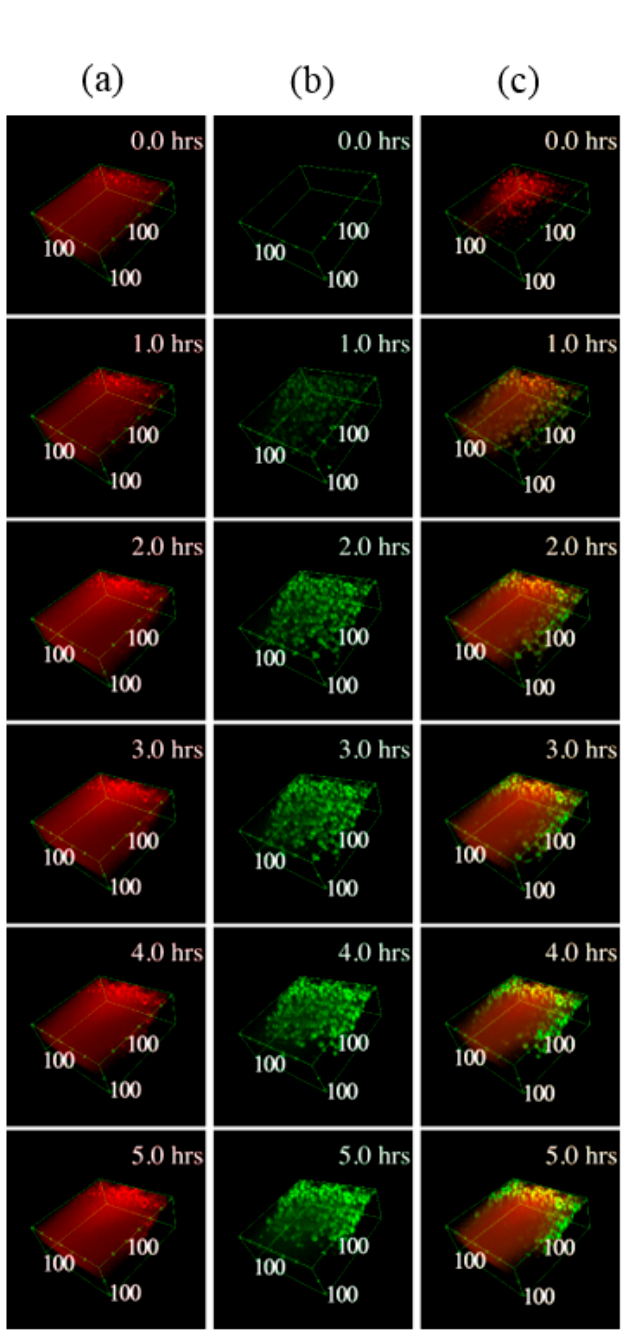
Figure 3. Three-dimensional (3D) reconstructions of the pellet micromass during the time-lapse. In column ( a ) the CARS signal at 2848 cm − 1 originating mainly by the cells lipid structures is shown in red, in column ( b ) the TPEF signal related to the EVs fluorescence is shown in green, while in column ( c ) the two channels are merged. In the top right corner of each image is depicted the related timeframe and close to the boundary box are shown the dimensions in μ m starting from the origin vertex.